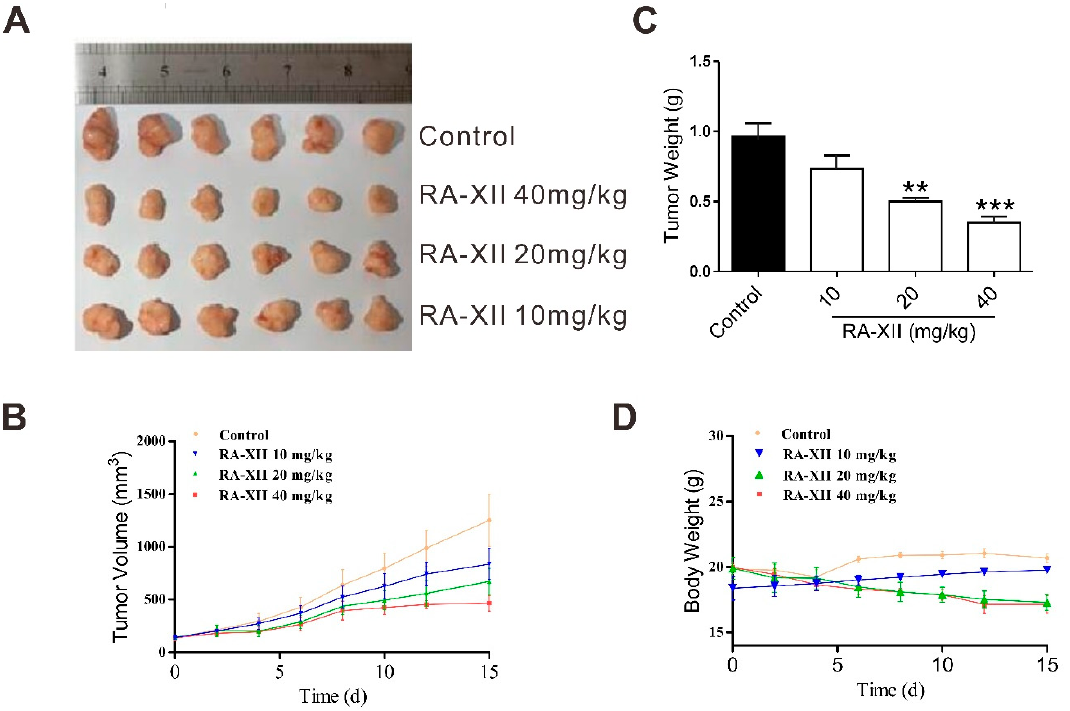
Figure 5. RA-XII exerts anti-tumor effects on the xenograft mouse model. Mice were treated with RA-XII at 10, 20, or 40 mg/kg intravenously thrice a week. After 15 days, mice were sacrificed and solid tumors were isolated. ( A ) Image of isolated tumors at the end of experiment. ( B ) Volume change of tumors. ( C ) Weight of tumors at the end of experiment. ( D ) Body weight change of the mice. Tumor size and body weight were recorded three times a week. n = 6. ** p < 0.01, *** p < 0.001, compared with vehicle control.